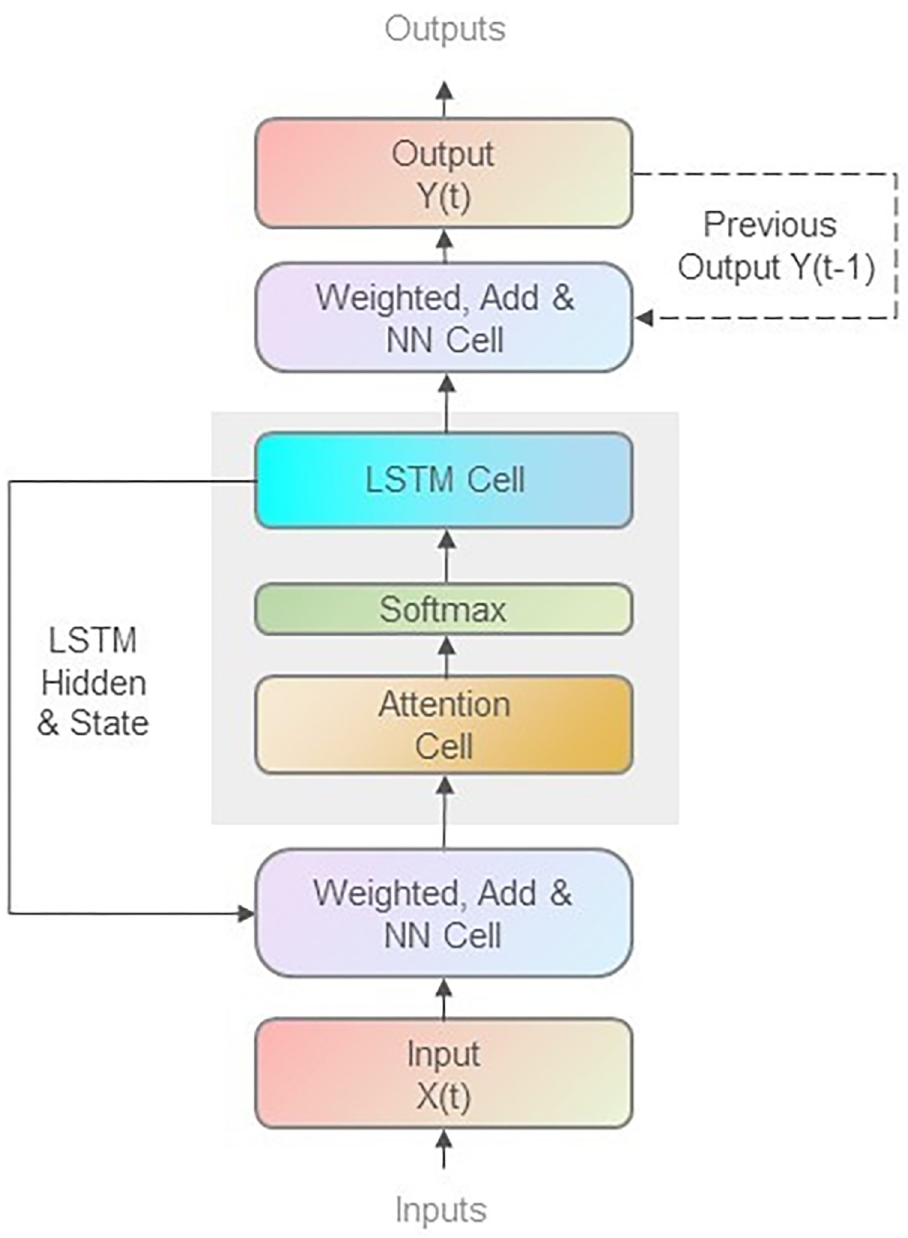
Fig 2. The structure diagram of our proposed attention-based LSTM model. The main structure of our proposed attention-based LSTM model is composed of Input, NN Cell, Attention Cell, Softmax, LSTM Cell, and Output modules. Corresponding to the mathematical expressions above, firstly the Input sequences X(t) will be weighted and add together with the weighted LSTM output Hidden and State data, then go through the NN Cell; secondly the data will flow to Attention Cell to generate the attention weighted data and then go into Softmax layer; thirdly the LSTM Cell will operate on the input data and output Hidden and State data from two directions, one is to output to the previous NN layer to operate with the data of the next sequence, and the other is output to the later NN layer for operating the model output Y(t). In order to gain a better training result for this model, we can also add a step that concatenating the previous output sequence data Y(t-1) with the LSTM Cell output to get the latest output sequence Y (t) in the last NN layer.